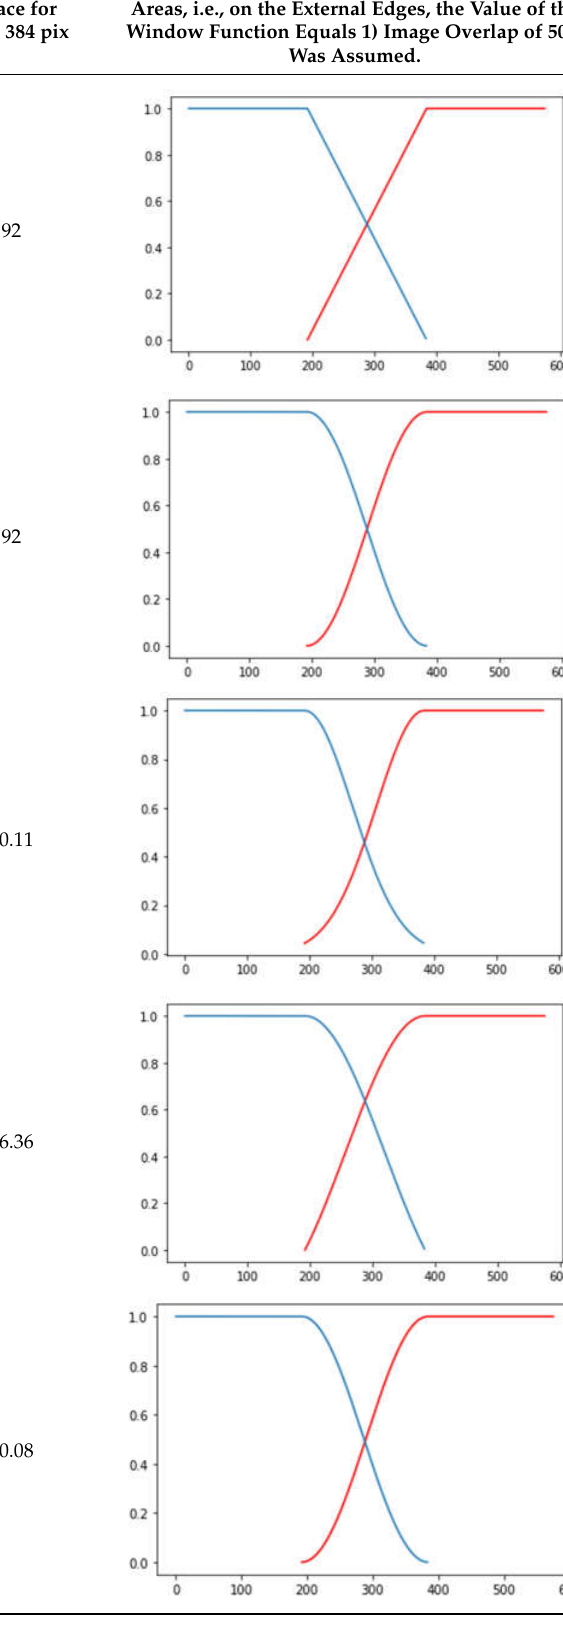
Figure (the Modification, When in Non-Overlapping Surface for Areas, i.e., on the External Edges, the Value of the Image 384 pix Window Function Equals 1) Image Overlap of 50% Was